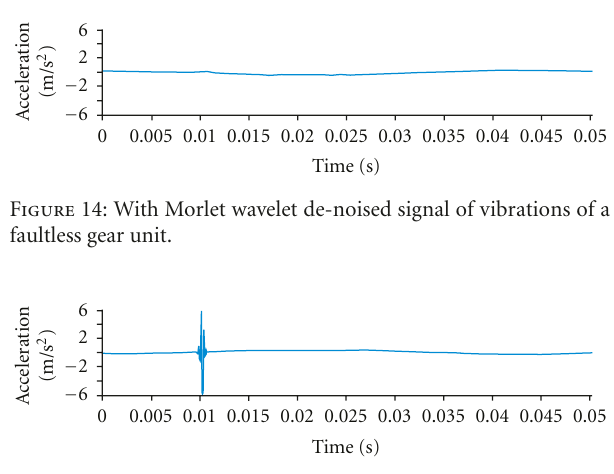
Figure 15: With Morlet wavelet de-noised signal of vibrations of a gear with a pinion with a